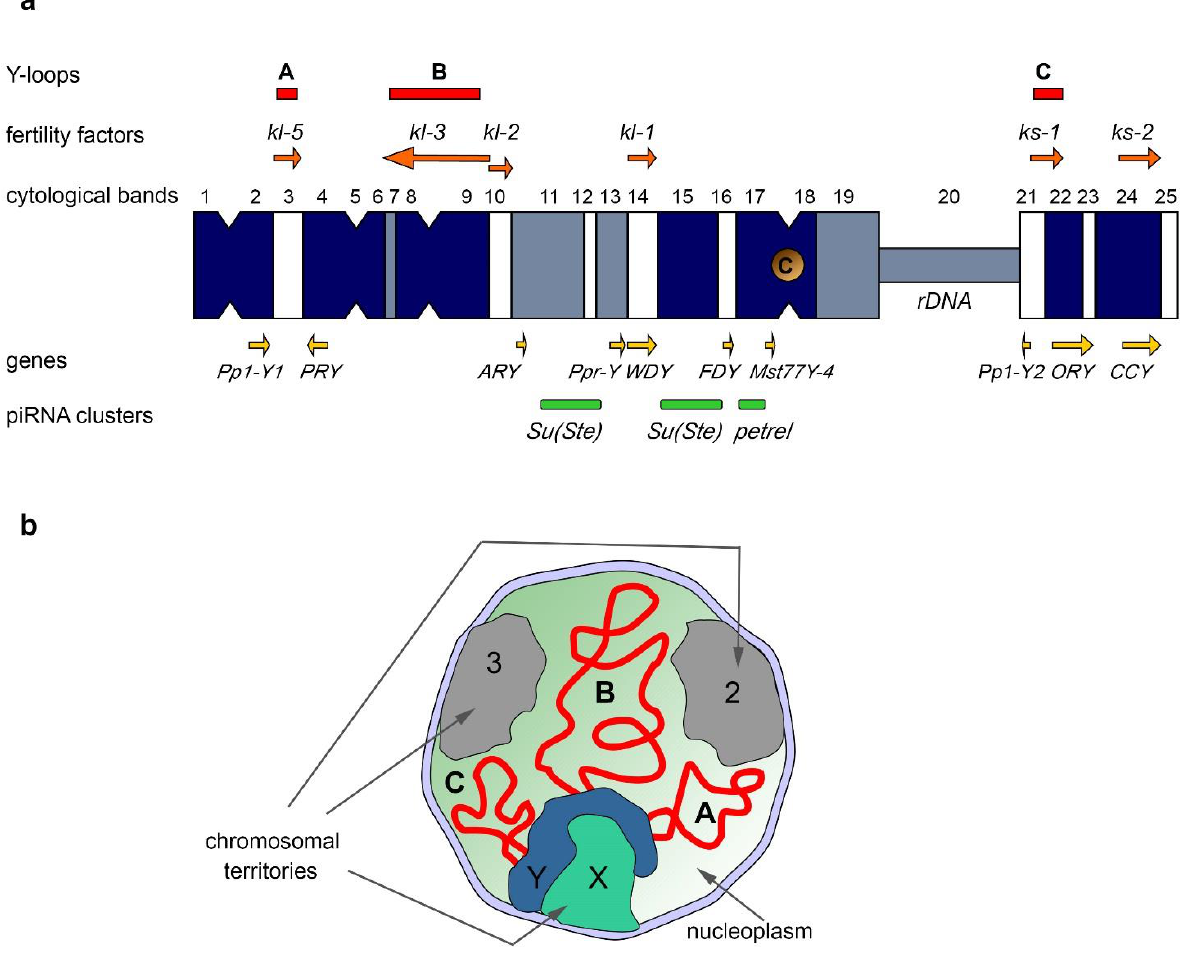
Figure 1. ( a ) The scheme of the Y chromosome of D. melanogaster . Cytological bands are shown in accordance with Hoechst 3325B banding, white bands represent no fluorescence. From top to bottom: cytological location of fertility factor genes (orange arrows) and corresponding Y-loops (red bars); Y chromosome scheme with cytological bands indicated; cytological location of the centromere (C), rDNA loci, and several genes (yellow arrows); cytological location of largest piRNA clusters (green bars). The scheme is modified from [6] according to data from [2,4,7]. ( b ) The scheme of Y-loop distribution in the nucleus of a primary spermatocyte in G2 phase. Chromatin forms three discrete chromosome territories that are adjacent to the inner nuclear membrane and consisted of paired chromosomes 2 and 3, and also X/Y. Transcriptionally active Y-loops A, B, and C are distributed in the nucleoplasm (thick red